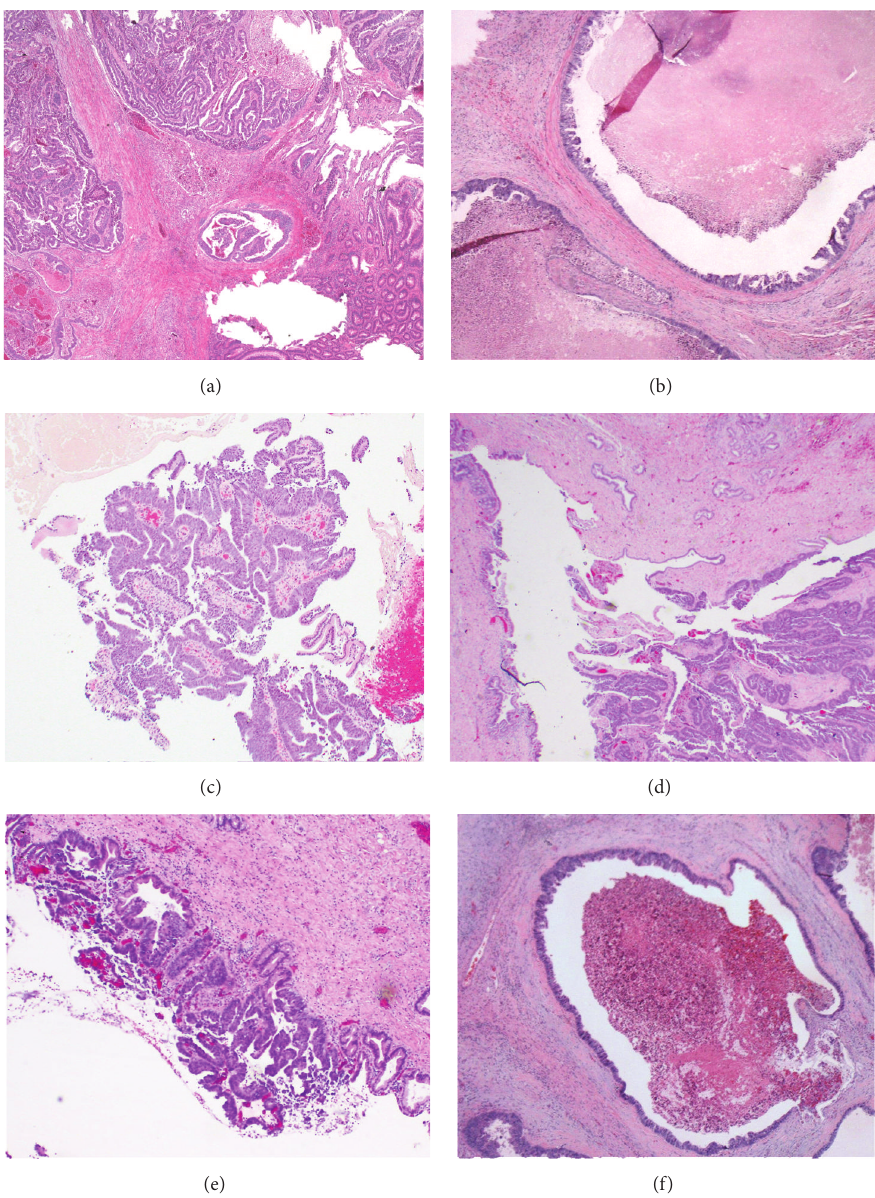
Figure 1: (a) Patient’s primary rectosigmoid adenocarcinoma. (b) Liver resection for CRC metastasis four years ago. (c) Biopsy of intrabiliary mass. ((d) and (e)) Resection of the intrabiliary metastasis. (f) Smaller liver nodular lesions. All images are H & E ( ×